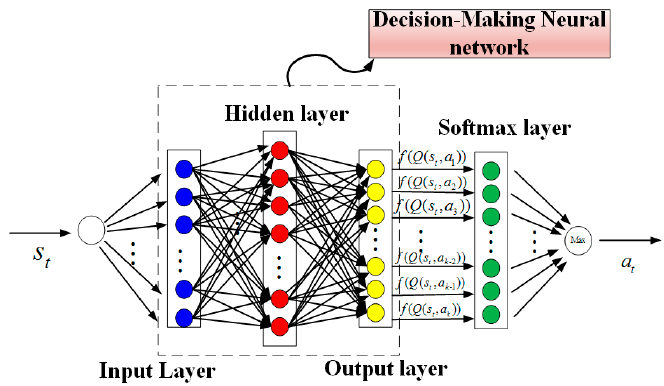
Figure 4. Decision-making neural network architecture.